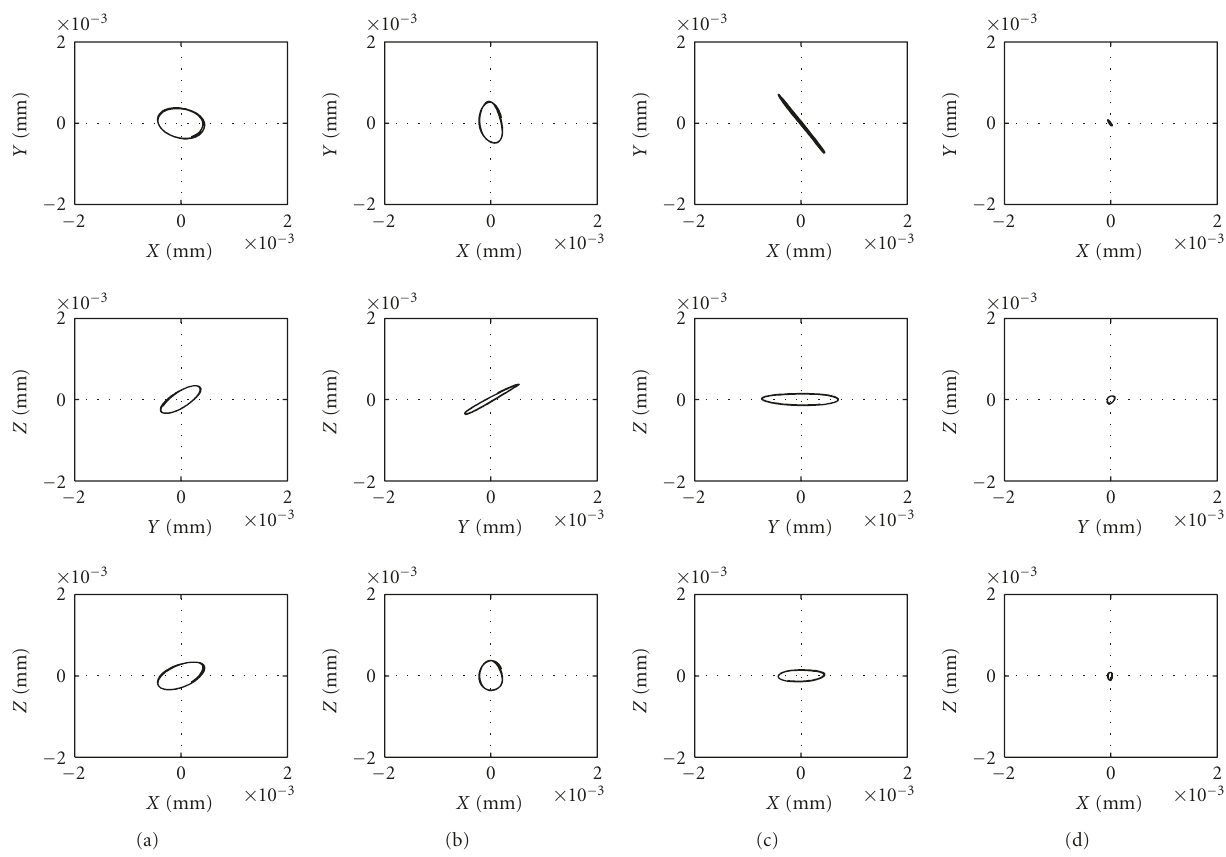
Figure 7: An example of the GL muscle belly trajectories over the ( x , y ), ( y , z ) and ( x , z ) planes, at di ff erent stimulation frequencies ((a) = 16Hz, (b) = 25 Hz, (c) = 40Hz, (d) = 50 Hz). The figure corresponds to P2 subject positioning.